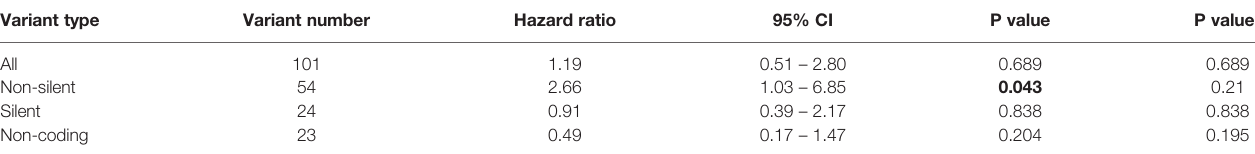
TABLE 2 | Ability of the somatic mutations to predict overall survival in breast cancer patients. Variant type